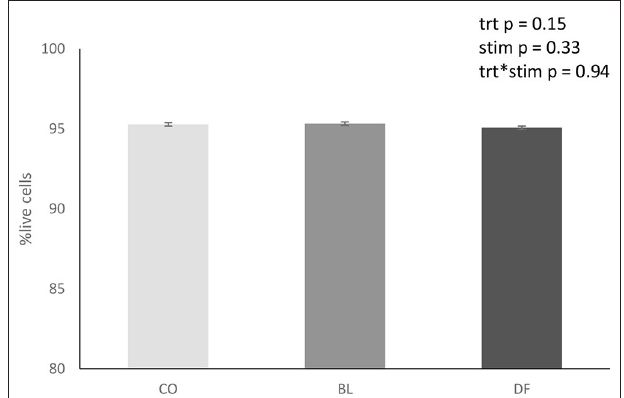
FIGURE 2 | Overall treatment viability of antral mucosal explants ± SEM collected from porcine stomachs ( n = 8) and cultured for 72h in sterile